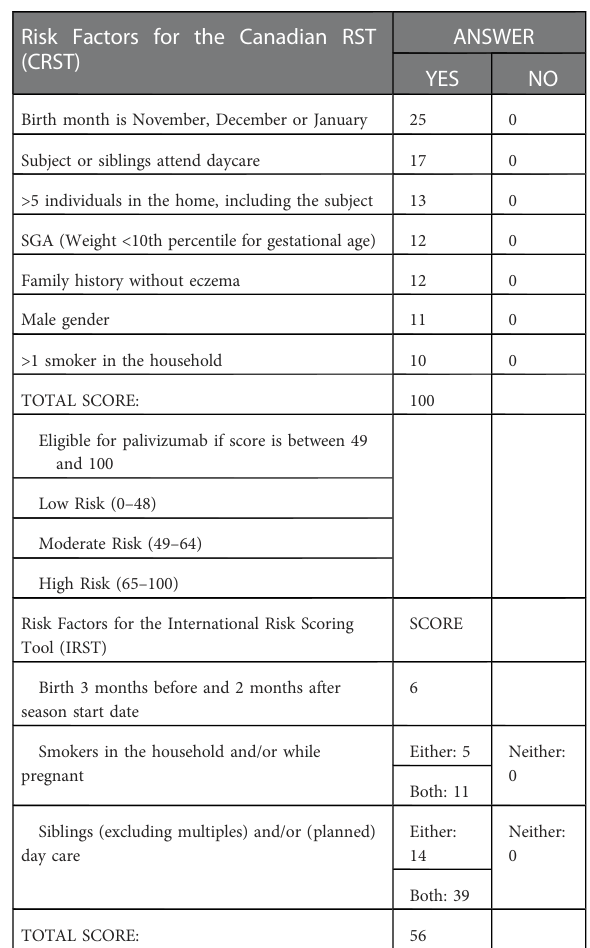
TABLE 1 Canadian and international risk scoring